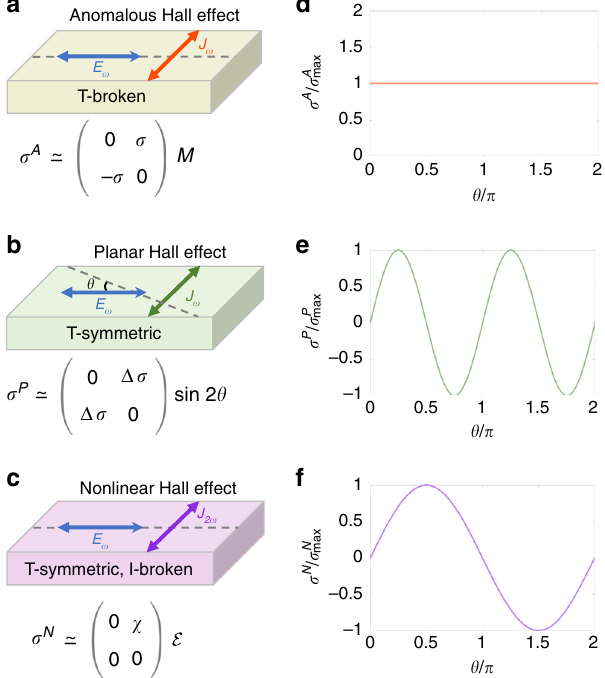
Fig. 1 Comparison of the linear and nonlinear Hall effects in the absence of the magnetic fi eld. Experimental setups and time-reversal symmetry of the anomalous ( a ), planar ( b ), and nonlinear Hall effects ( c ). σ A is the anomalous Hall conductivity, which is always anti-symmetric 3 . M represents the magnetization. σ P is the planar Hall conductivity. Δ σ (cid:5) σ σ , where σ and σ refer to the longitudinal conductivities k (cid:2) ? k ? along the two principal axes. θ is the angle between the driving current and the k principal axis (the dashed lines). σ N is the nonlinear Hall conductivity, which is proportional to the magnitude of the driving electric fi eld E . The element of the nonlinear Hall response tensor χ is due to inversion symmetry breaking along the dashed line. d – f Angular dependence can